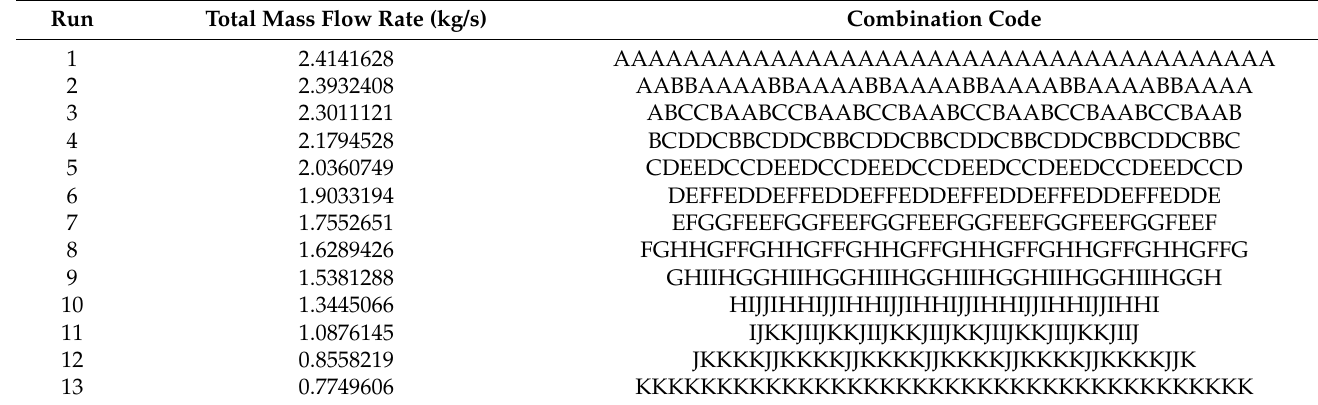
Table 7. Combinations of mass flow rates for six stall